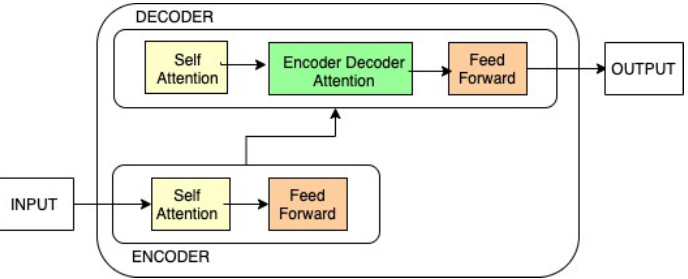
Figure 1. Illustration of the Transformer architecture based on Figure 1 in [3].